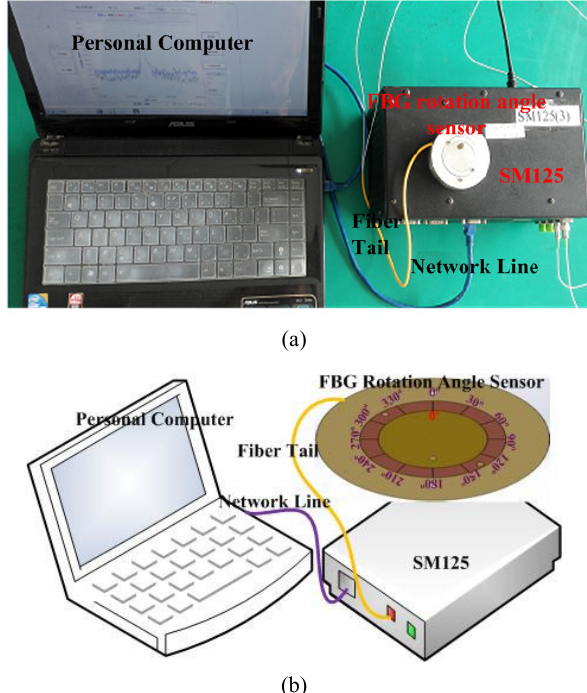
Fig. 5 Rotation angle calibration experimental platform: (a) instrument and (b) framework.